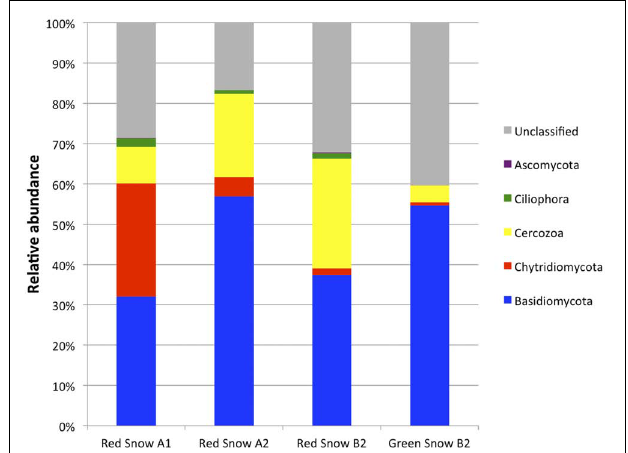
FIGURE 4 | Non-algal community composition based on 18S rRNA gene sequencing of three red snow samples (red snow A1, A2, and B2) and one green snow sample (green snow B2) from Mt. Asahi. The community composition is represented by grouping the OTUs at the phylum